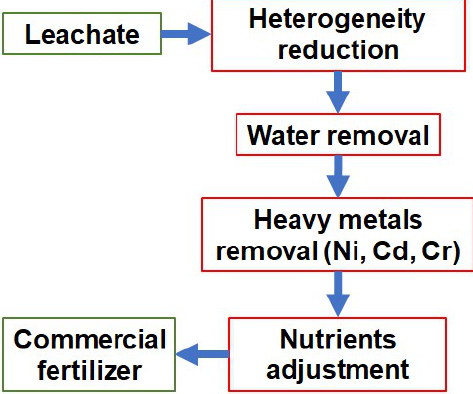
Figure 3. Proposed simplified flowsheet for a conversion process of the leachate to commercial fertilizers.